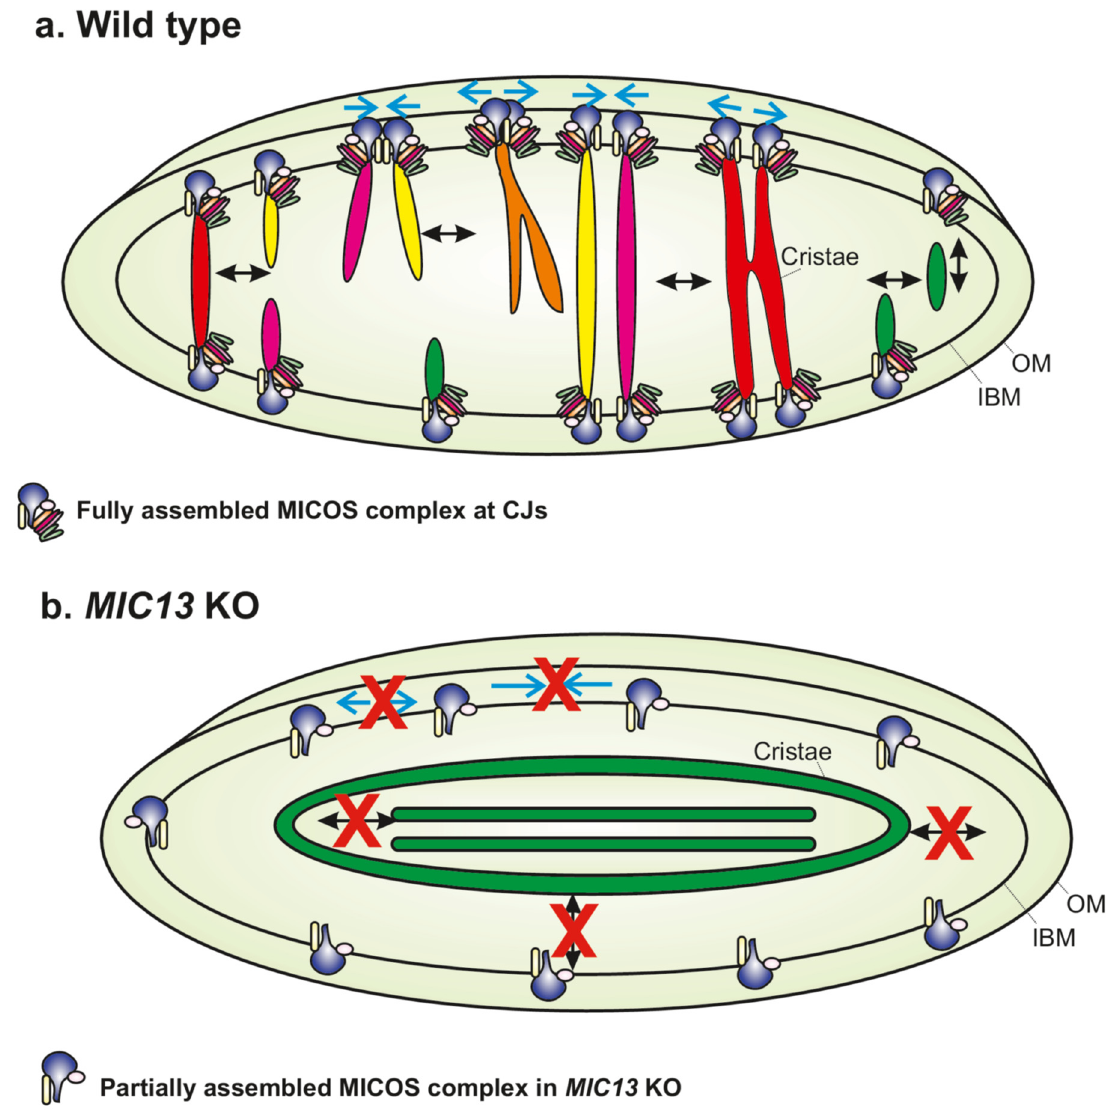
Figure 2. The MICOS complex regulates apparent cristae fusion and fission cycles. ( a ) Scheme depicts the various kinds of crista and CJ dynamics that are found in a mammalian cell. CJs formed by the MICOS complex move towards and away from each other in order to undergo merging and splitting events, respectively, as shown by cyan arrows. Similarly, cristae show a dynamic movement that involves continuous fusion and fission cycles in a balanced and reversible manner. In various instances, merging CJs can bring with them the adjoining cristae and facilitate their fusion along their length, resulting in the formation of a cristae network that resembles the ‘X’ or ‘Y’ letter. Cristae fusion is immediately followed by fission or vice versa. Cristae can also detach from the inner boundary membrane (IBM) to form cristae vesicles (shown as green cristae). These cristae vesicles can re-fuse to the IBM. OM represents outer membrane. ( b ) In MIC13 KO, cristae are arranged as concentric rings or internal stacks that are not connected to the IBM. The movement of CJs and cristae is drastically reduced in MIC13 KO